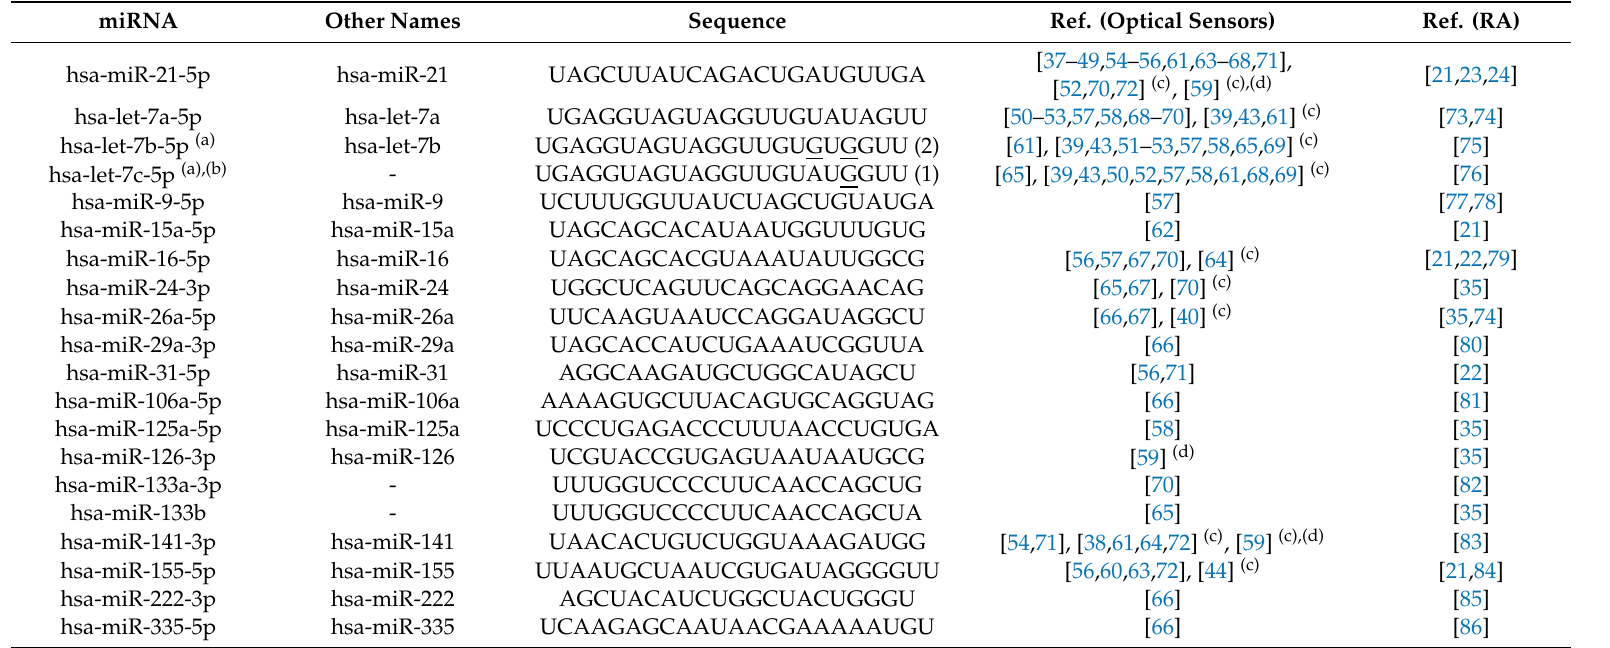
Table 2. Summary of miRNAs associated with rheumatoid arthritis (RA) mentioned in Section